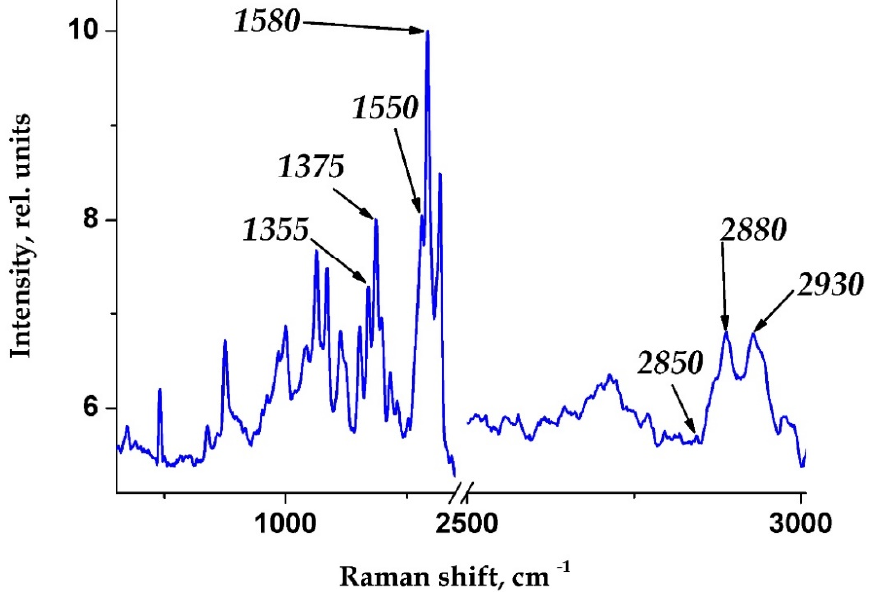
Figure 1. Raman spectrum of hemoglobin hematoporphyrin obtained from erythrocytes of a healthy person (control group).